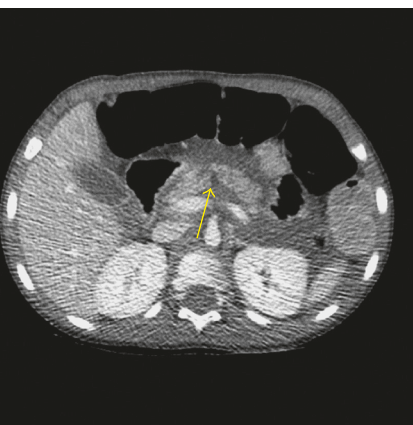
Figure 2: MRI showing complete transection through the proximal portion of the body of the